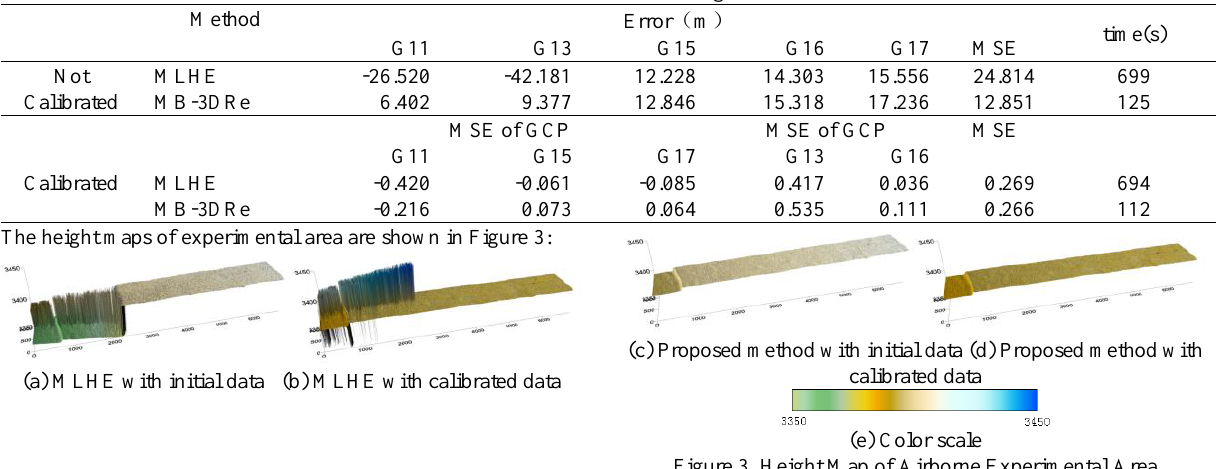
Figure 3. Height Map of Airborne Experimental